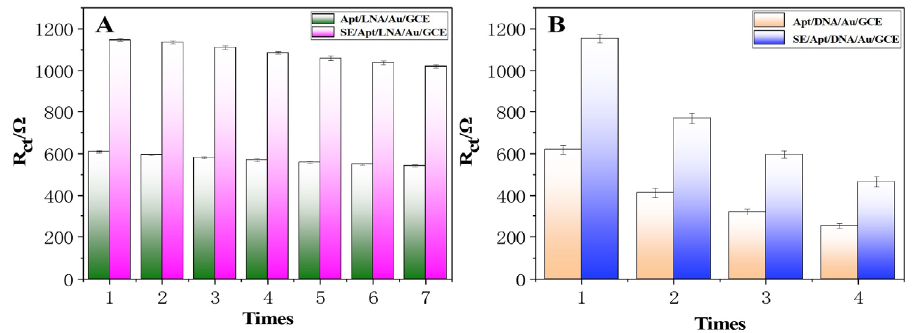
Figure 6. ( A ) Regenerative sensor with LNA as the connecting element. ( B ) Regenerative sensor with DNA as the connecting element.